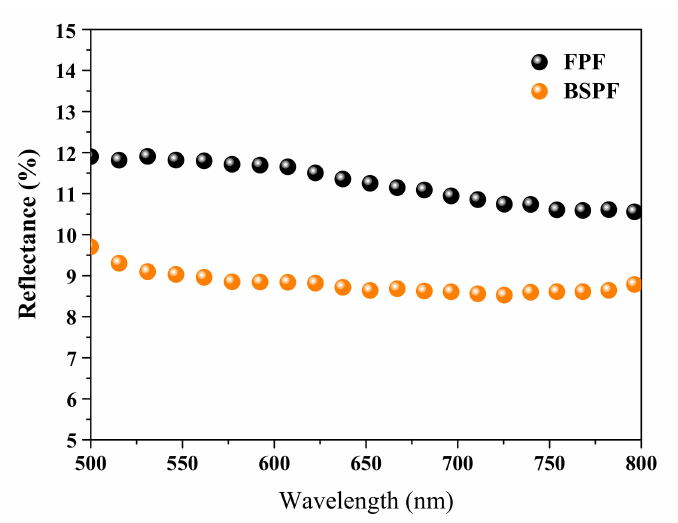
Figure 8. Reflectance spectra of the FPF (black) and the BSPF